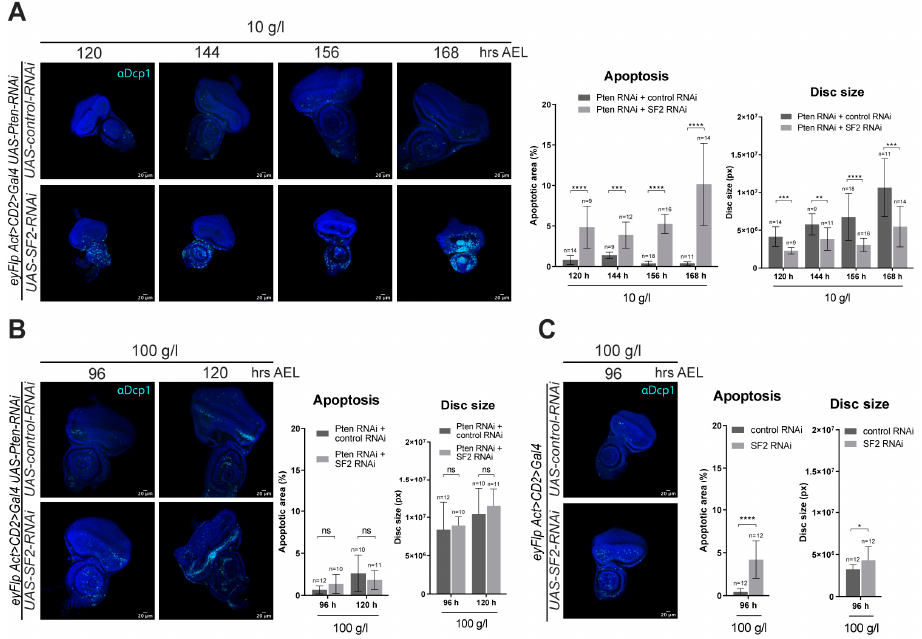
Figure 2. SF2 knockdown suppresses the growth of Pten -deficient eye imaginal discs. The knockdowns were achieved by using the eyFlp Act > CD2 > Gal4; UAS-Pten-RNAi tester line. ( A ) Eye discs upon NR were dissected at 120, 144, 156 and 160 h after egg laying (AEL). The growth of Pten -deficient discs is blocked by SF2 silencing. Discs with SF2 knockdown become increasingly apoptotic, as visualized by cleaved-Dcp1 staining. ( B ) Discs from normal conditions were dissected 96 and 120 h AEL. SF2 knockdown does not a ff ect the growth of Pten -deficient discs under normal conditions. ( C ) SF2 knockdown also causes some apoptosis in control discs, without a ff ecting growth. * p < 0.05, ** p < 0.01, *** p < 0.001, **** p < 0.0001, ns: not significant. Scale bars represent 20 µ